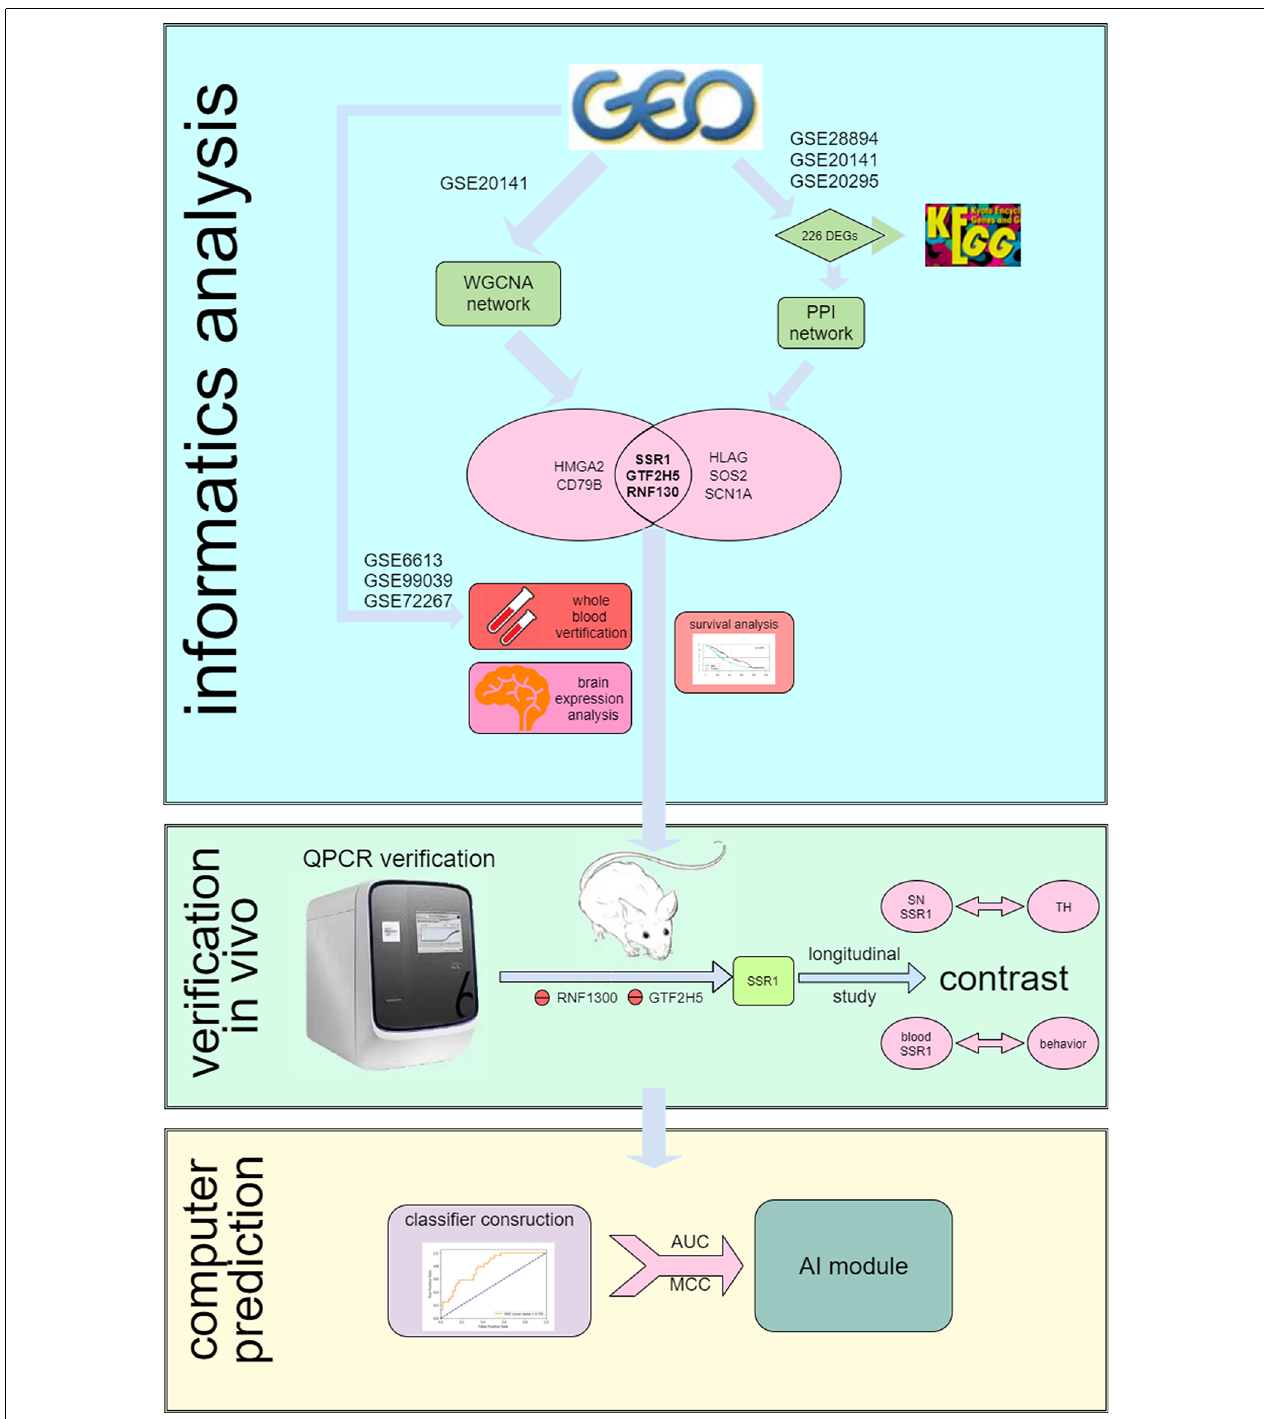
FIGURE 1 | Flow chart of the analysis